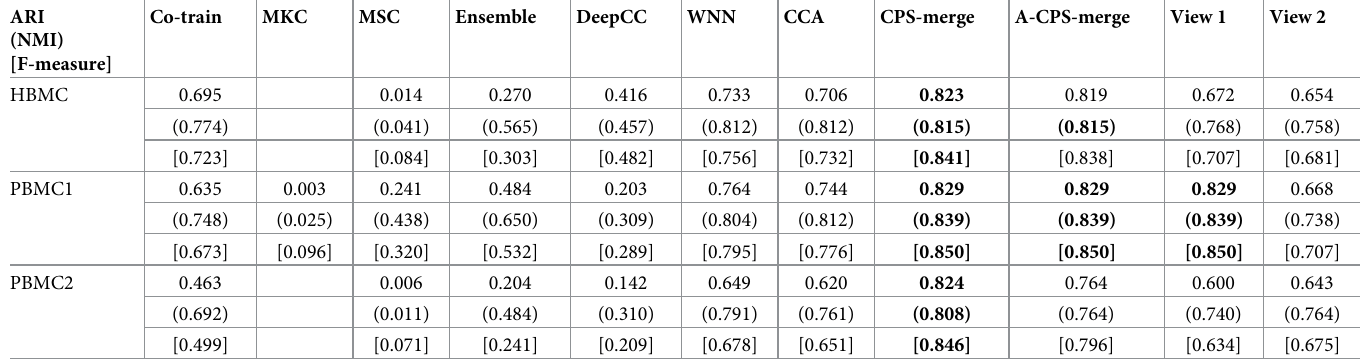
Table 2. Clustering results on three muti-view datasets (HBMC, PBMC1 and PBMC2) obtained by 8 methods (first 8 columns). Performance is measured by ARI, NMI and F-measure. Columns View 1 and View 2 are single-view clustering results on each dataset, where View 1 refers to RNA data in datasets and View 2 refers to ADT (protein) data in HBMC and PBMC2, and ATAC data in PBMC1. The highest ARI, NMI and F-measure achieved for each dataset are in